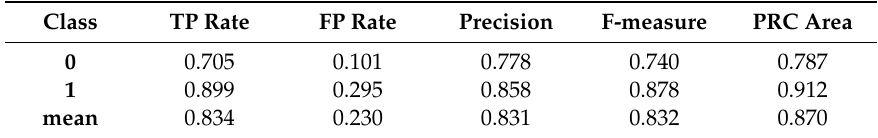
Table 1. Predictive performances reached by the model for the blood–brain barrier (BBB) permeation (0 and 1 indicate non-permeant and permeant molecules,